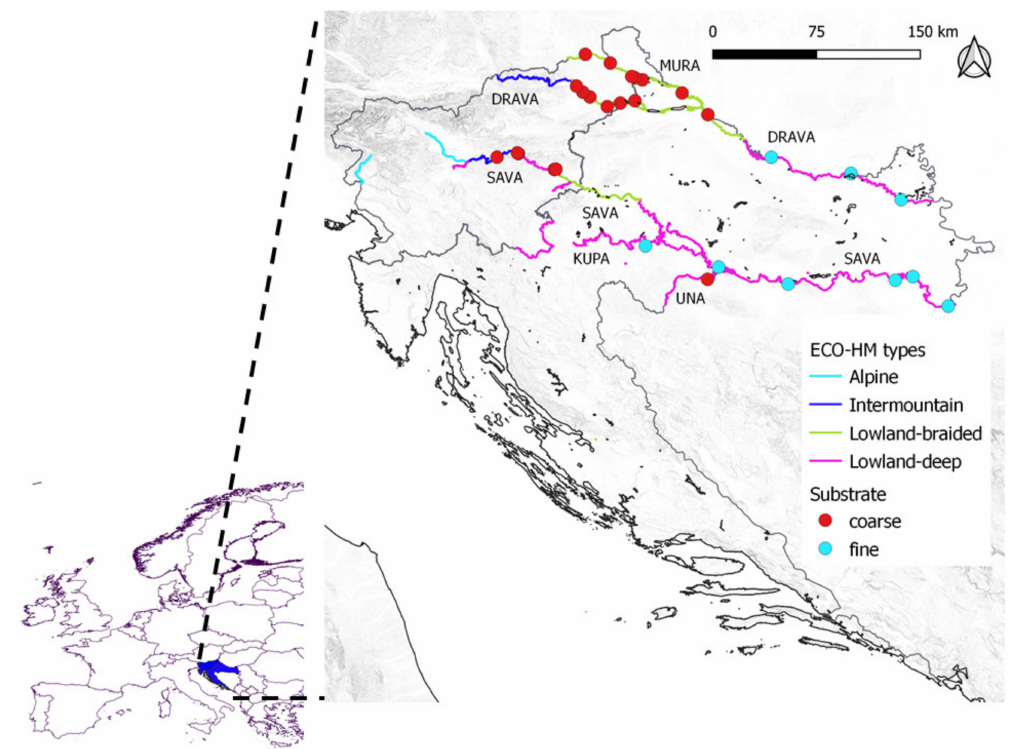
Figure 1. Study area with large river eco-hydromorphological (ECO-HM) types and near-natural sampling sites with prevailing natural substrate (closed